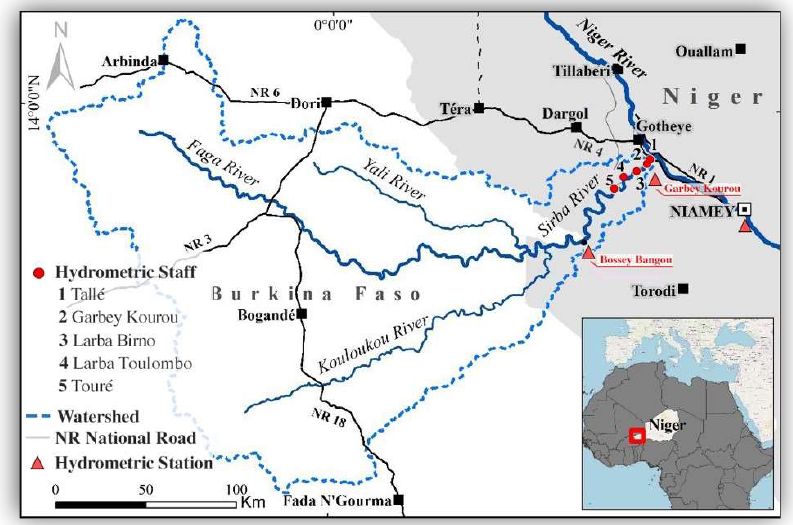
Figure 1. SLAPIS study area: the Sirba River Basin with the hydrometric stations, the hydrometric staffs, Sirba River and watershed boundaries. Bottom right: Africa overview with Niger study area.